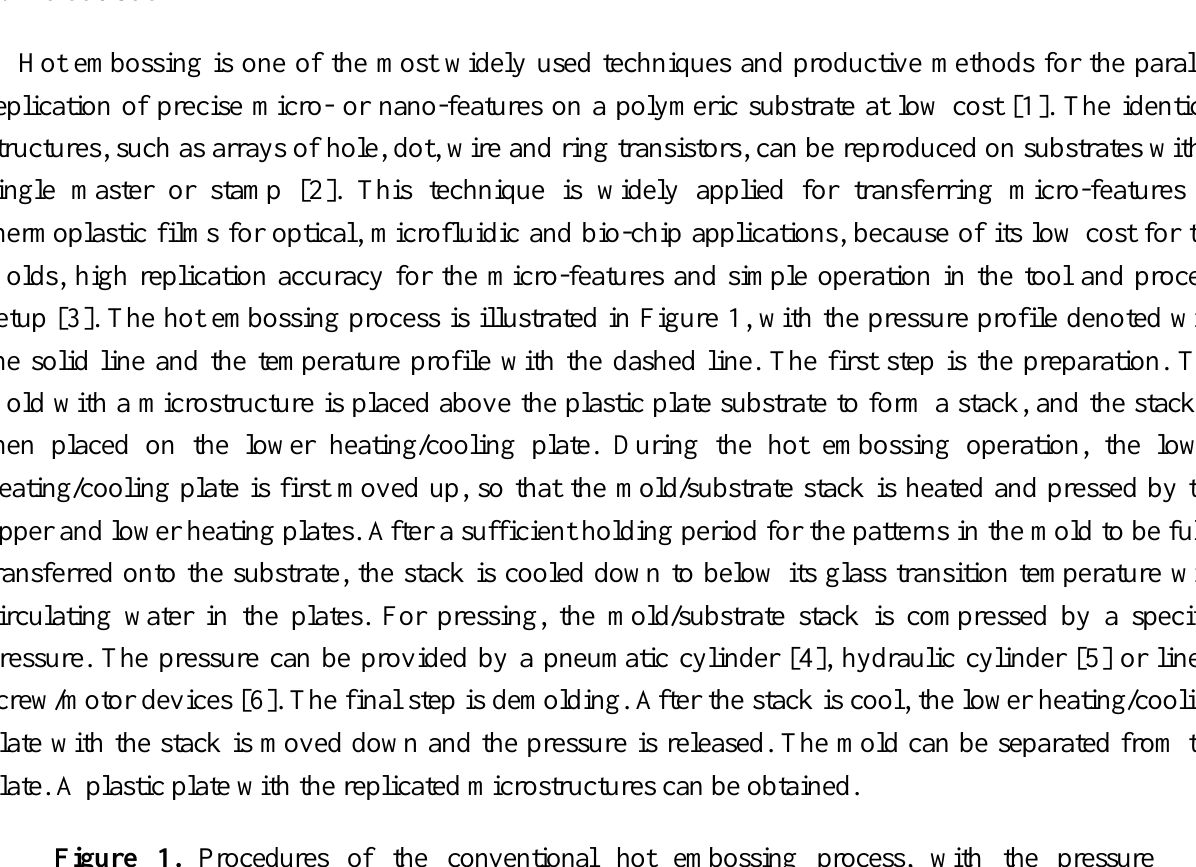
Figure 1. Procedures of the conventional hot embossing process, with the pressure ( Solid Line ) and temperature profiles ( Dashed Line ) illustrated; the procedures, including preparation, heating, holding, cooling and demolding